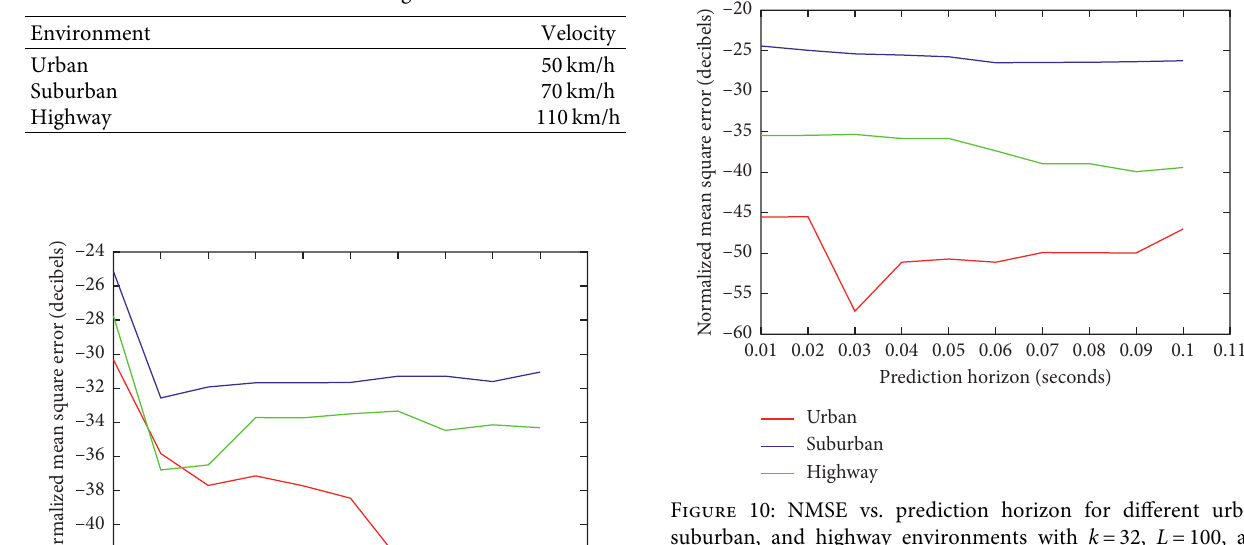
Figure 7: Computational time vs. number of paths of 􏽢 h and h : � v � 50km/h and τ � 20 ms. v t r Table 2: Velocities characterizing environments.